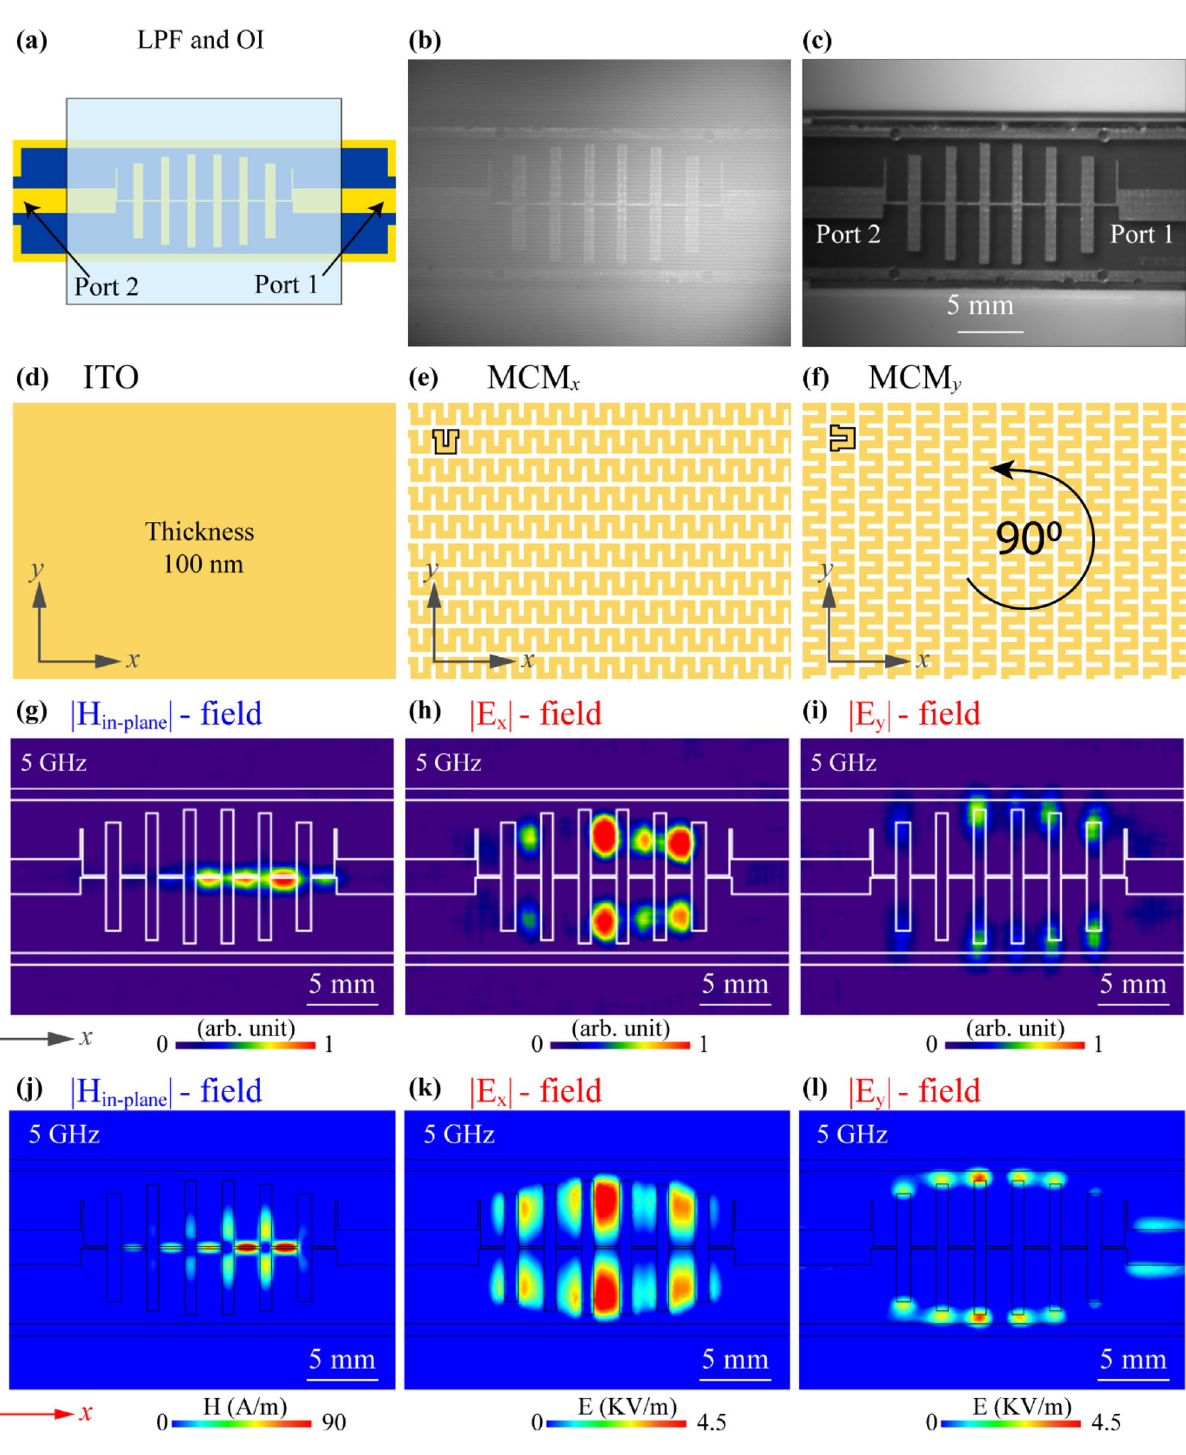
were normalized together. Experimental and simulation results show that microwave power is localized only in the nearest regions of the microstrip lines. After moving the indicator by a total 2.5 mm from the DUT surface,